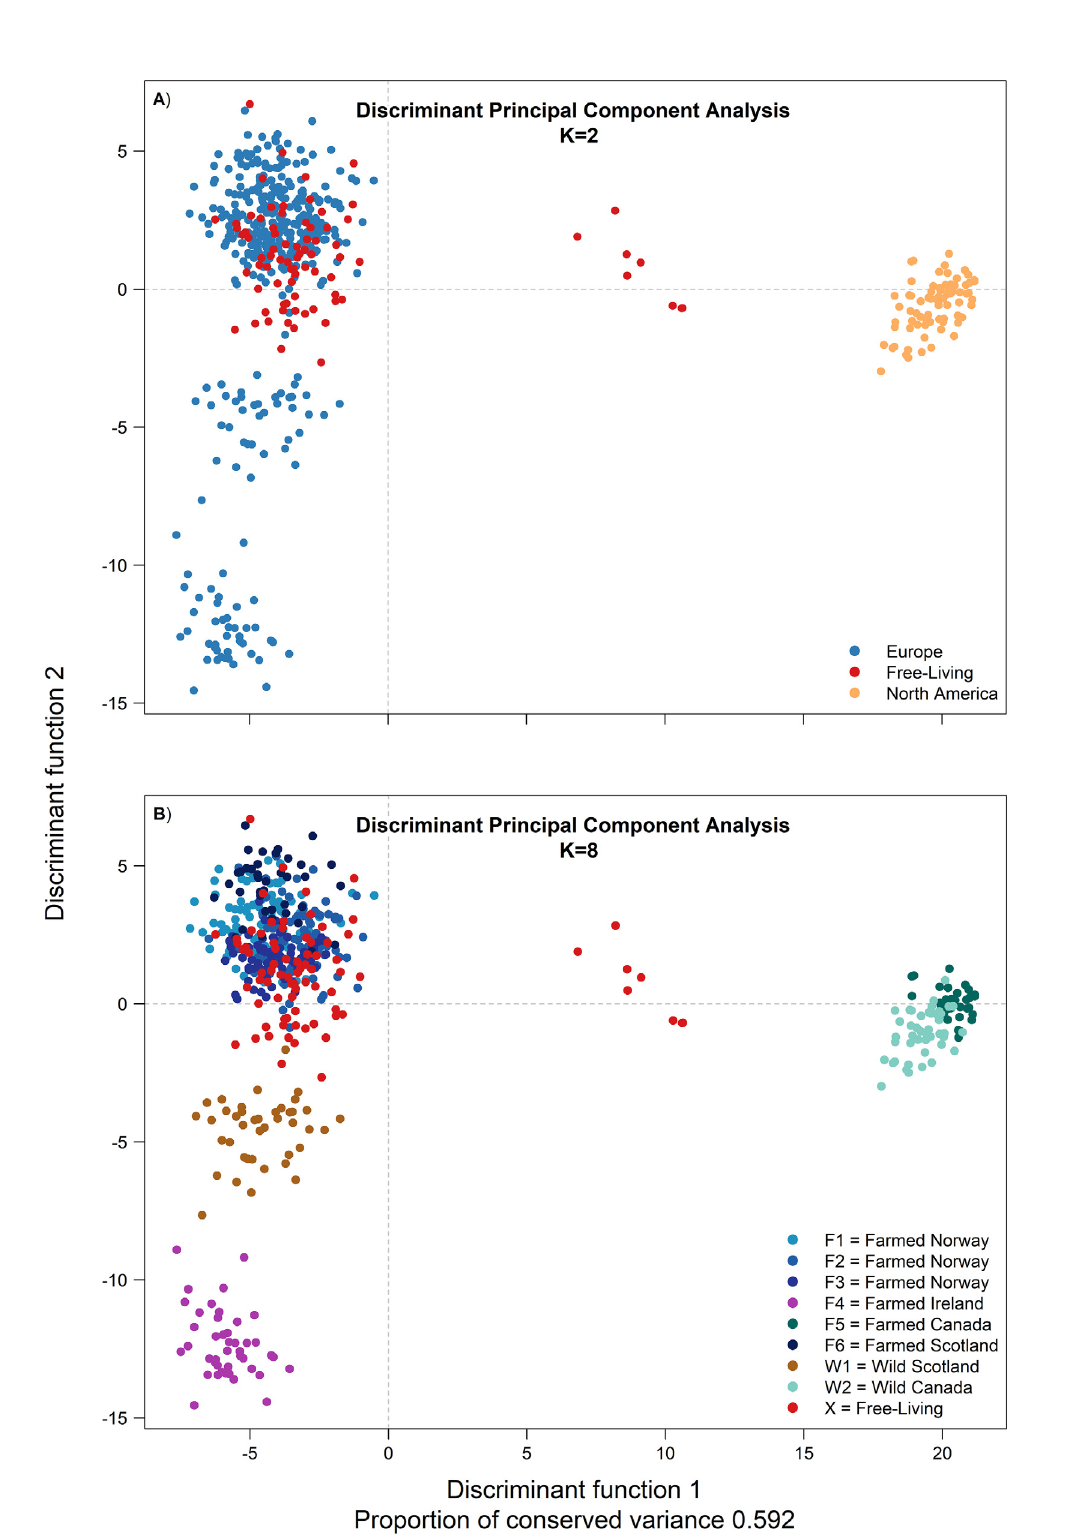
Fig. 6. Discriminant analysis of principal components of free-living and reference collections of Atlantic salmon. (A) First dis- criminant function distinguishes between European and North American populations; 73 free-living individuals were posi- tioned within the European cluster, whereas 7 were positioned at an intermediate distance from the North American cluster. (B) Second discriminant function distinguishes between farmed Norway, farmed Ireland, and wild Scotland